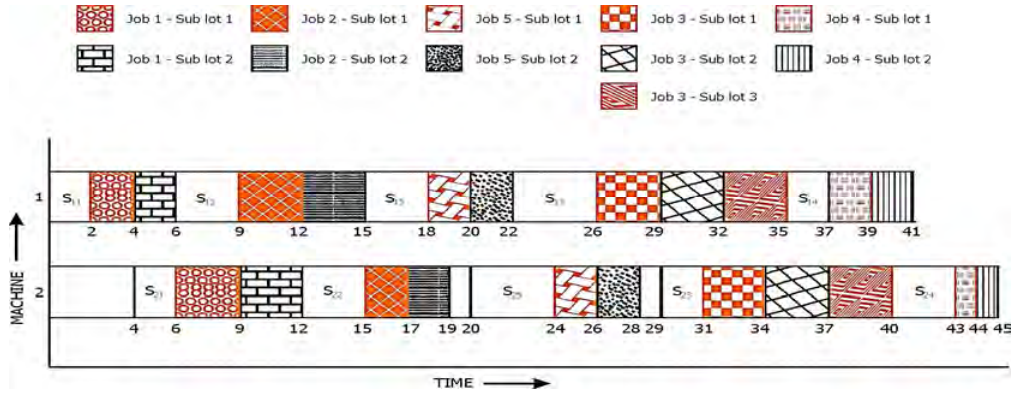
Fig.3 - Schedule for the sequence 1-2-5-3-4